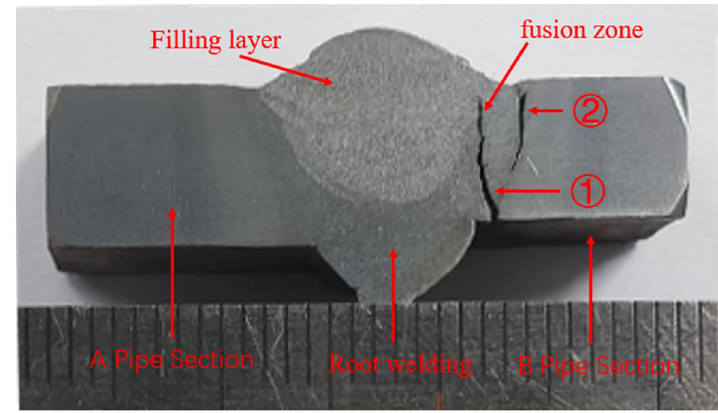
Fig. 20 Microstructure 1 at the crack of 1# (right side of position ① in Fig.